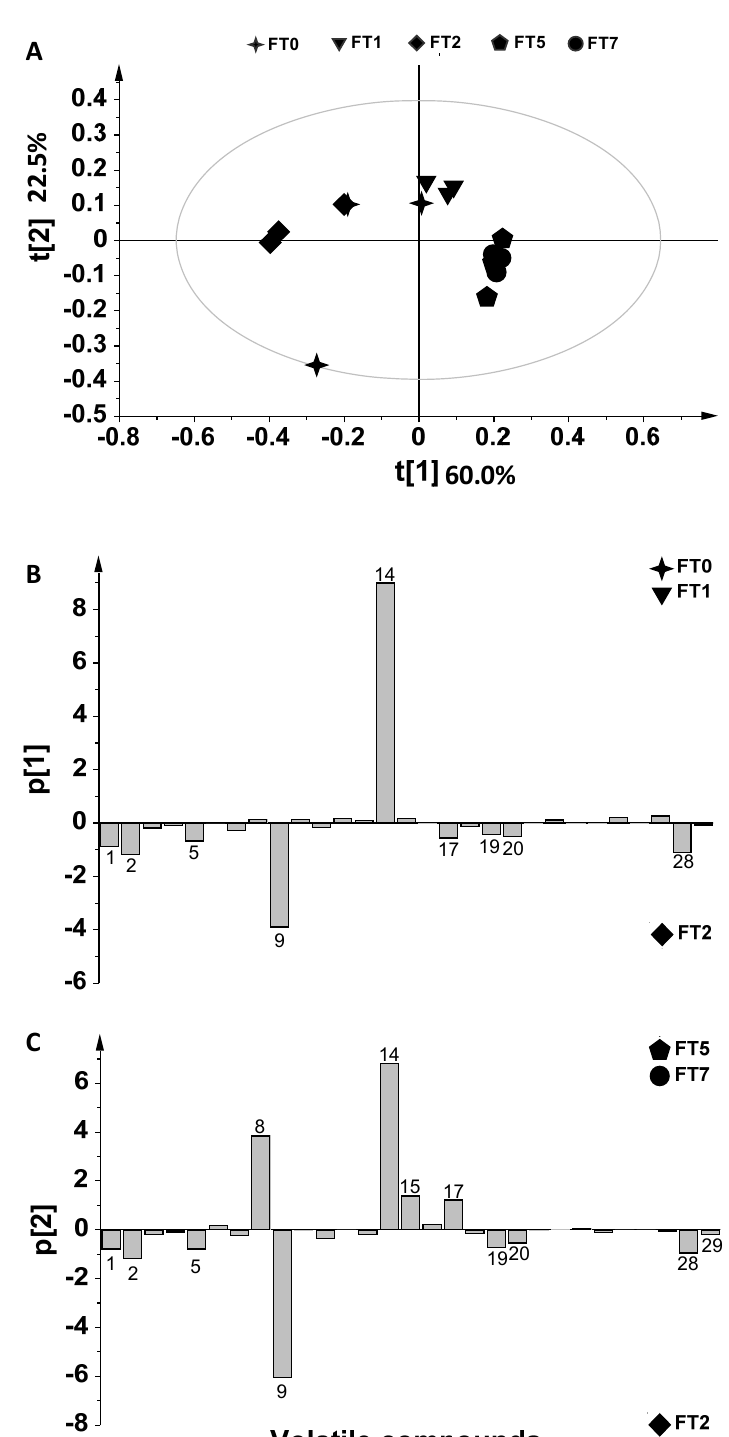
Figure 3. ( A ) PCA t[1]/t[2]score plot of SPME-GC/MS of FT samples analyzed at Days 0, 1, 2, 5 and 7. Filled symbols: FT samples. ( B ) p1 loading contribution plots related to the t[1]/t[2] PCA score plot. Positive values indicate metabolites identified at Days 0 (FT0), 1 (FT1); negative values refer to metabolites detected at Day 2 (FT2). ( C ) p2 loading contribution plots related to the t[1]/t[2] PCA score plot. Positive values indicate metabolites identified at Days 5 (FT5) and 7 (FT7); negative values refer to metabolites detected at Day 2